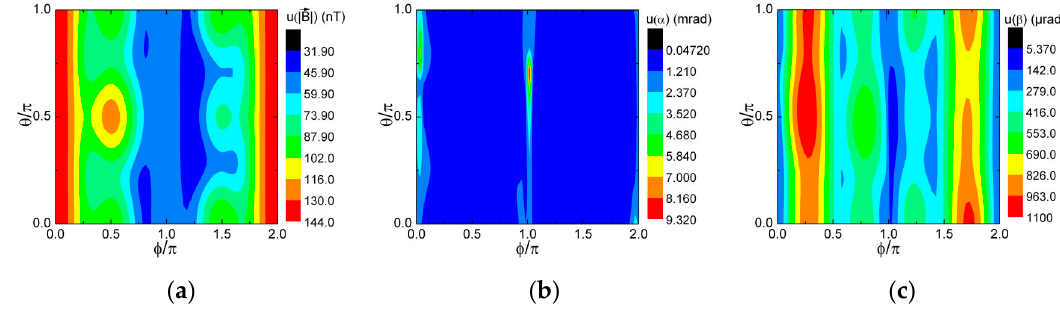
Figure 3. Estimated uncertainties of the spherical components of the magnetic field in the LCF as a function of the spherical angles ( φ , θ ) for I 0 = 1 A: ( a ) Uncertainty of the magnetic field strength; ( b ) Uncertainty of the magnetic field azimuth angle; ( c ) Uncertainty of the magnetic field zenith angle.